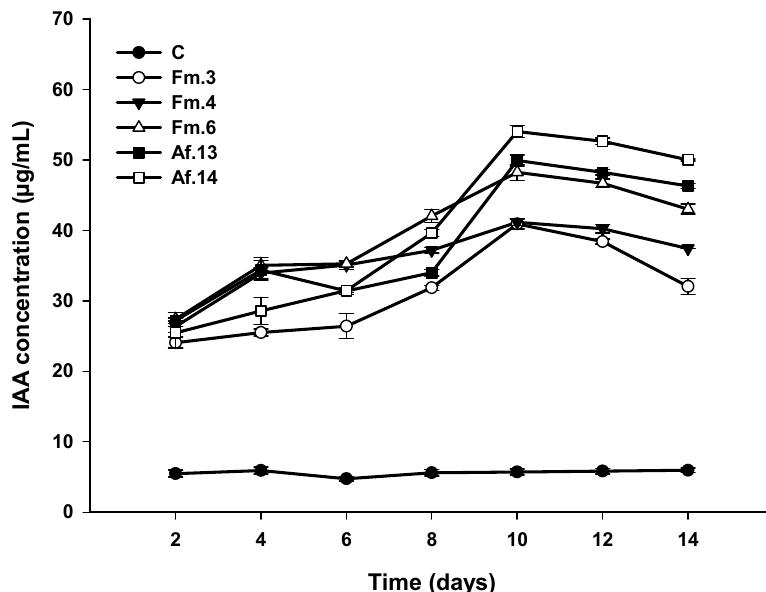
Figure 4. IAA production by the most potent bacterial strains in the presence of 5 mg mL − 1 tryptophan and over 14 days. C, controls without any bacterial inoculation. Identity of the bacterial isolates is available in Table 2. At each time point, bars with the same letter did not di ff er significantly at a significant level of ( p ≤ 0.05) by Tukey’s test, ( n = 3).